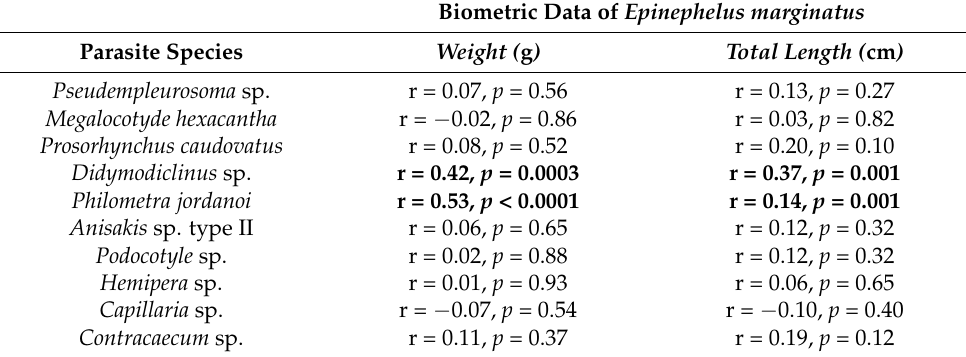
Table 2. Correlation between biometric data of Epinephelus marginatus and parasites’ prevalence.